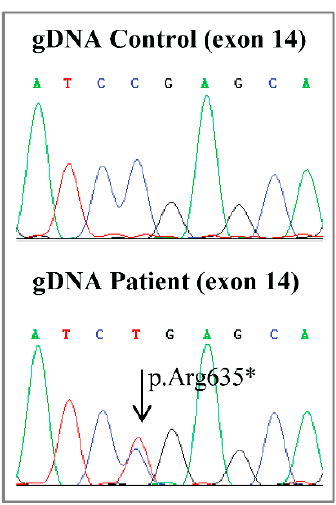
Figure A1. Sequence analysis of LAMB3 exon 14 identifies the heterozygous p.Arg635* null mutation. Panels show the electropherograms of LAMB3 exon 14 sequence obtained from the genomic DNA (gDNA) of a normal control (upper) as compared to the sequence obtained from the gDNA of the patient (lower), who harbors the heterozygous C-to-T transition leading to the p.Arg635* nonsense mutation (arrow).